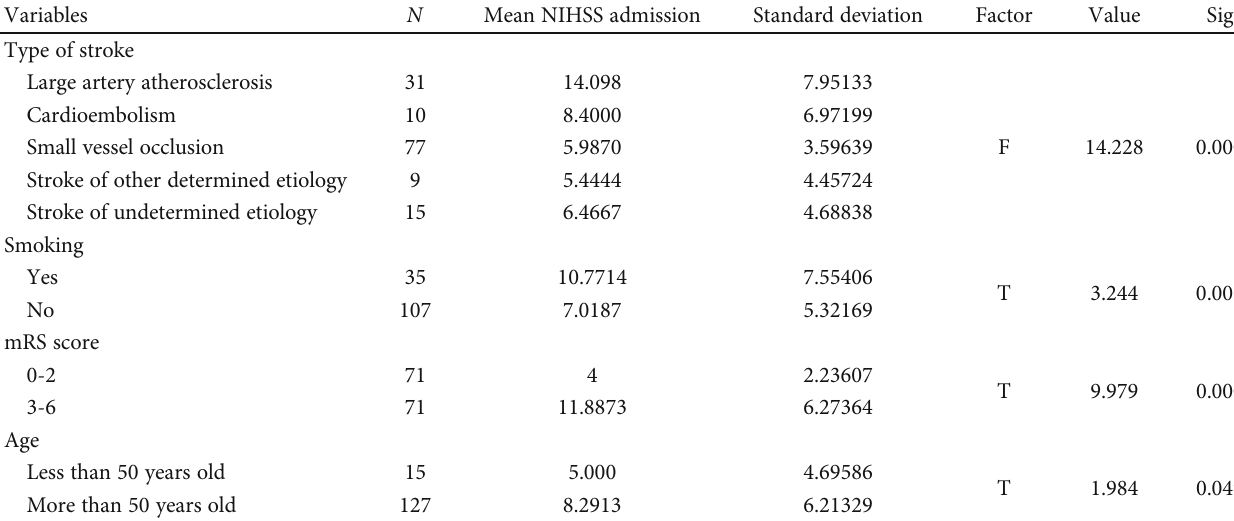
Table 7: Variables with statistically signi fi cant correlation with the admission NIHSS score.